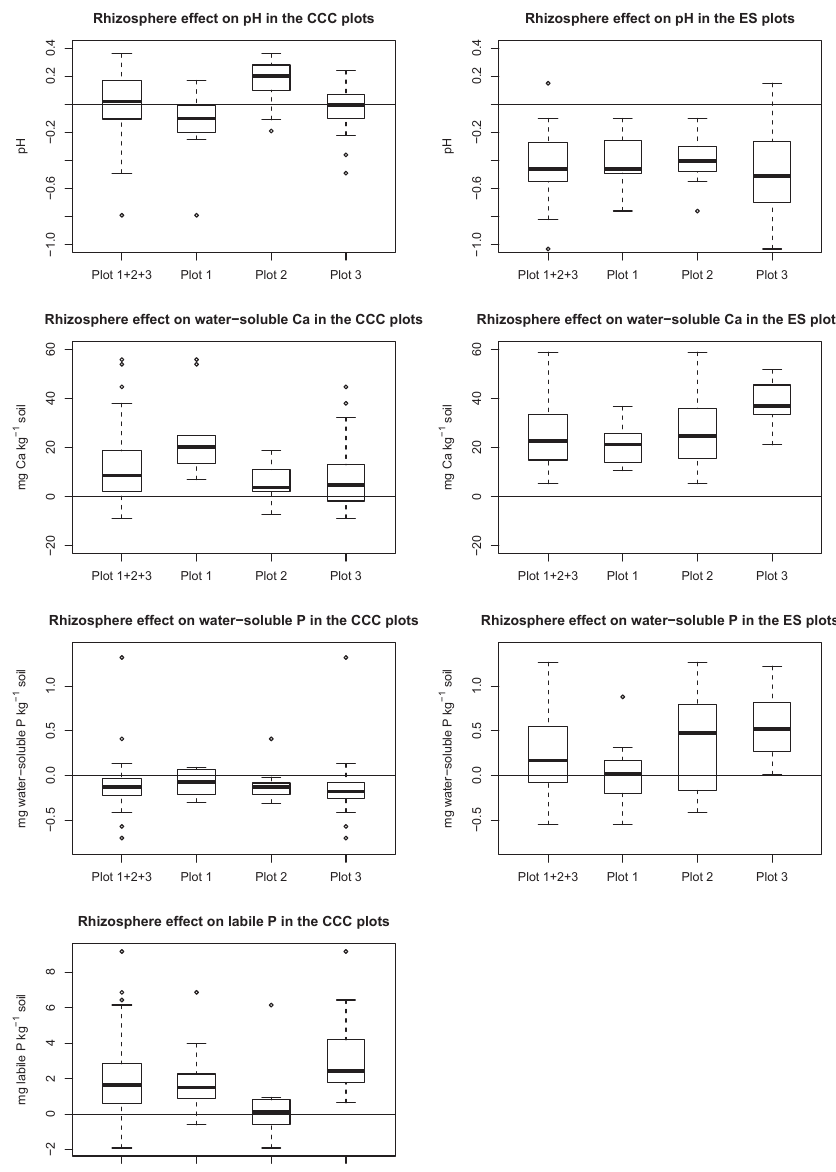
Fig. 6. The rhizosphere effect for pH, water-soluble Ca, water-soluble P and labile P on the plots with low (plot 1), intermediate (plot 2), high (plot 3) vegetation density and the pooled data for the three plots (plot 1+2+3) on the Chicken Creek Catchment (CCC) and the experimental site (ES) is calculated as the difference between the value for the respective parameter in the soil attached to the root and the value in the remaining soil of cubic samples taken from the top 10cm of the soil profile. Boxplots illustrate the median (horizontal line), the interquartile range (box), 1.5 times the interquartile range (whiskers) and